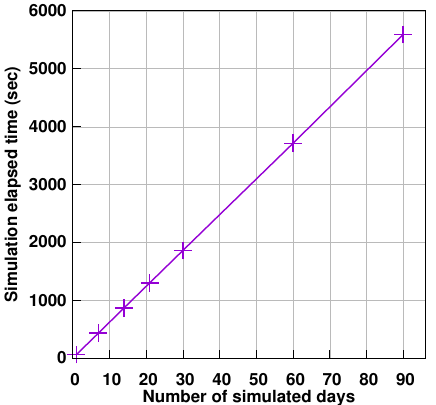
Figure 19. Analysis of Algorithm